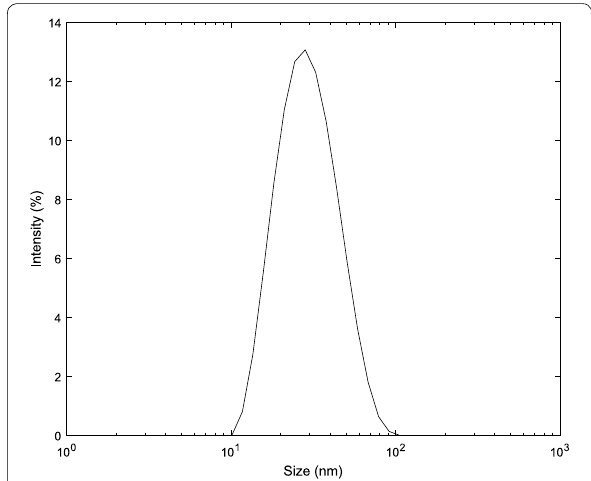
Fig. 1 Example of particle size distribution for a Ludox ® TM-40 silica sol from DLS measurement. Note that the x-axis is logarithmic. The distribution is a classical lognormal with particle size from 10